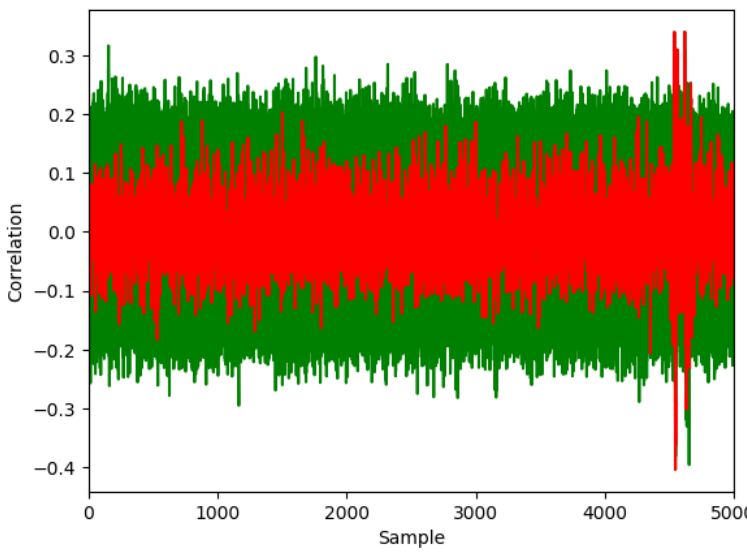
Figure 8: Correlation of all candidates for the second key byte. The correlation of the correct key is shown in